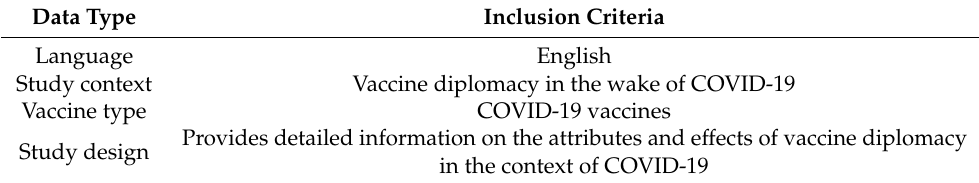
Table 2. Study inclusion criteria.